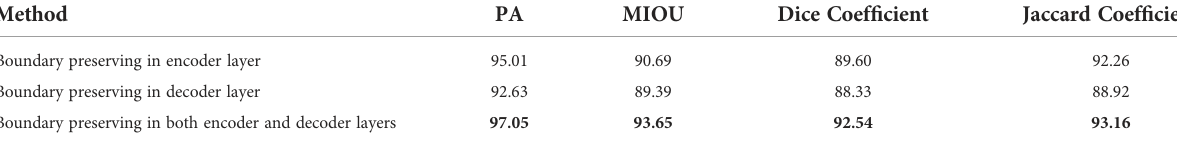
Boundary sampled points Bold values means best values.